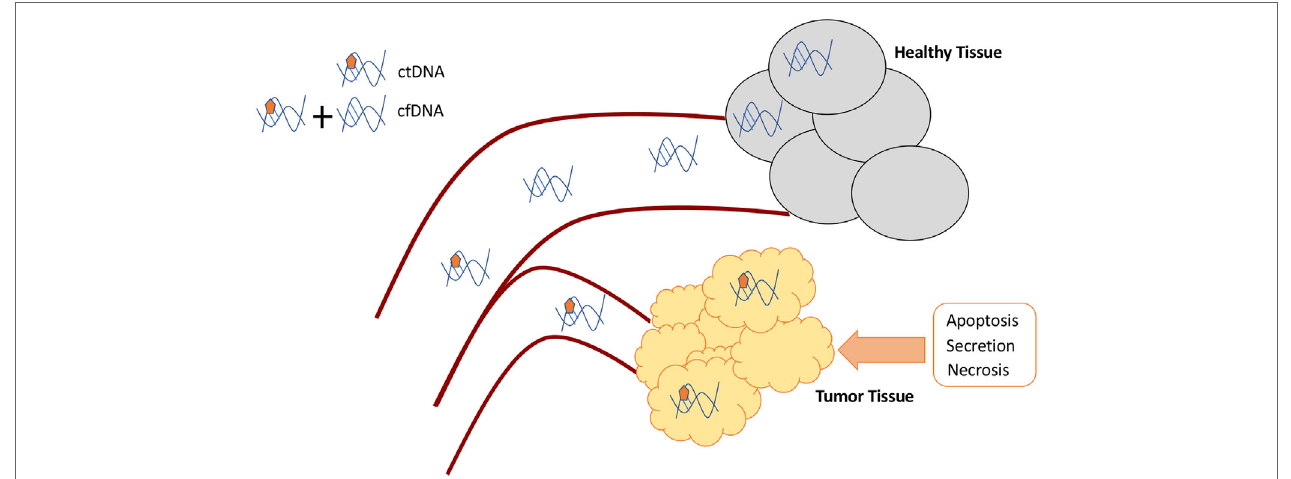
FigURe 1 | Circulating DNA generation and